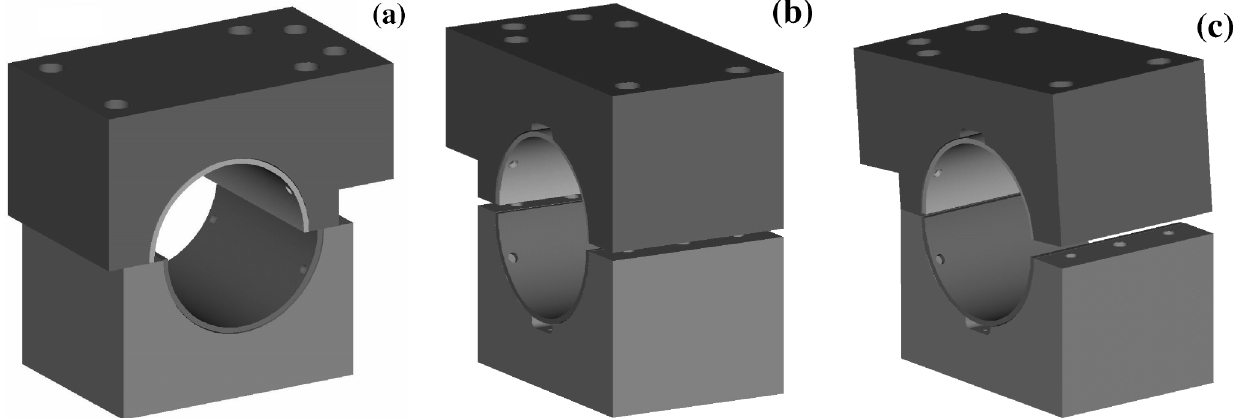
FIG. 8. Magnet errors implemented in MAG-PC for calculations of multipole content. (a) Symmetrical horizontal shift of magnet halves, (b) symmetrical vertical shift of magnet halves, and (c) edge rotation of upper magnet half. The errors are greatly exaggerated in the